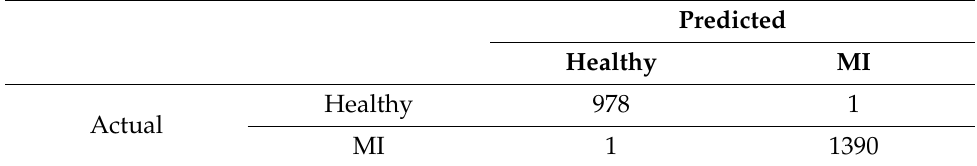
Table 4. Confusion matrix for one-trail of hold-out CV for MI detection.